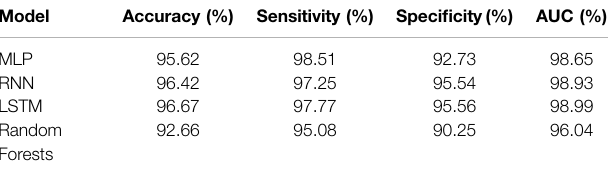
TABLE 2 | Accuracy, sensitivity and speci fi city, and AUC and training